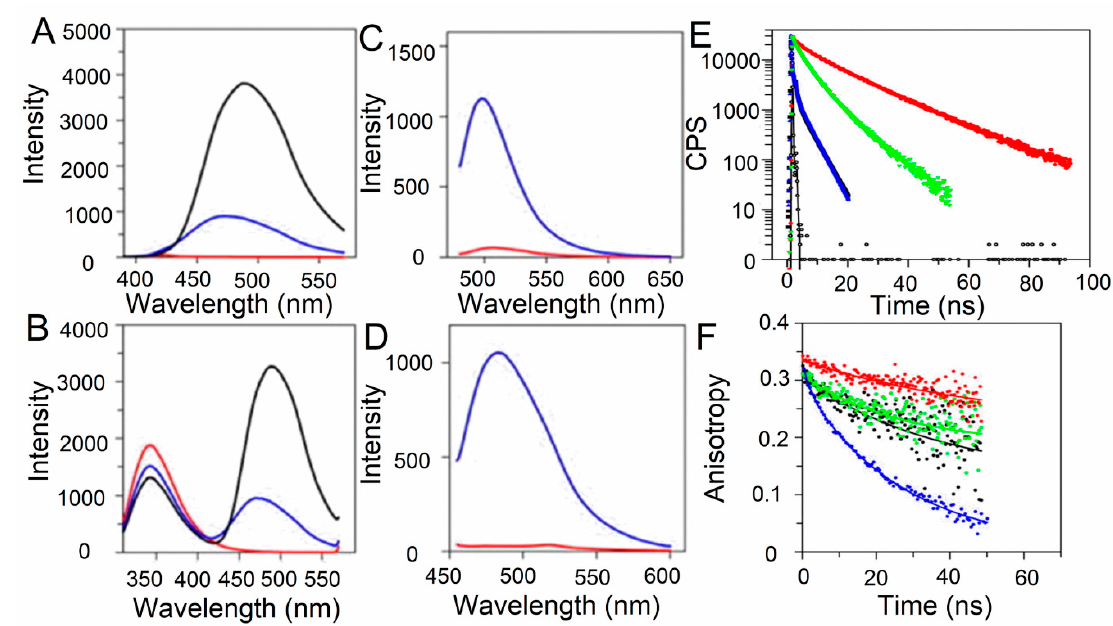
Figure 9. Fluorescence evaluation of the aggregation of TTR protein. ( A ) Fluorescence Spectra of ANS (blue line) and Bis-ANS (black line), after direct excitation, when bound to proto-fibrillar and spherical aggregates of TTR. The control without probes is presented in red. ( B ) Emission spectra excitation at 290 nm the proto-fibrillar and spherical aggregates of TTR in the presence of ANS (blue line) and Bis-ANS (black lines) and without probe (red line). ( C ) DCVJ spectra in the presence of native TTR (red line) and misfolded oligomers of TTR (blue line). ( D ) ThioT spectra in the presence of native TTR (red line) and misfolded oligomers of TTR (blue line). ( E ) Time-resolved fluorescence of the different probes bound to native TTR. ANS (red circles) or Bis-ANS (green triangles). DCVJ (blue triangles) and ThT (black squares) were bound to the misfolded aggregates of TTR after 1 h incubation. The ThT curve is hidden behind the DCVJ curve in the figure due to very similar decay profiles. The lamp response is indicated with open black circles. ( F ) ANS anisotropy decays of aggregates of TTR incubated for 24 h at different monomer concentrations: 2 µM (black), 4 µM (green), and 8 µM (red). As a comparison, the trace for native tetrameric TTR is shown in blue. This Figure was recreated and adapted from Lindgren et al. [119].